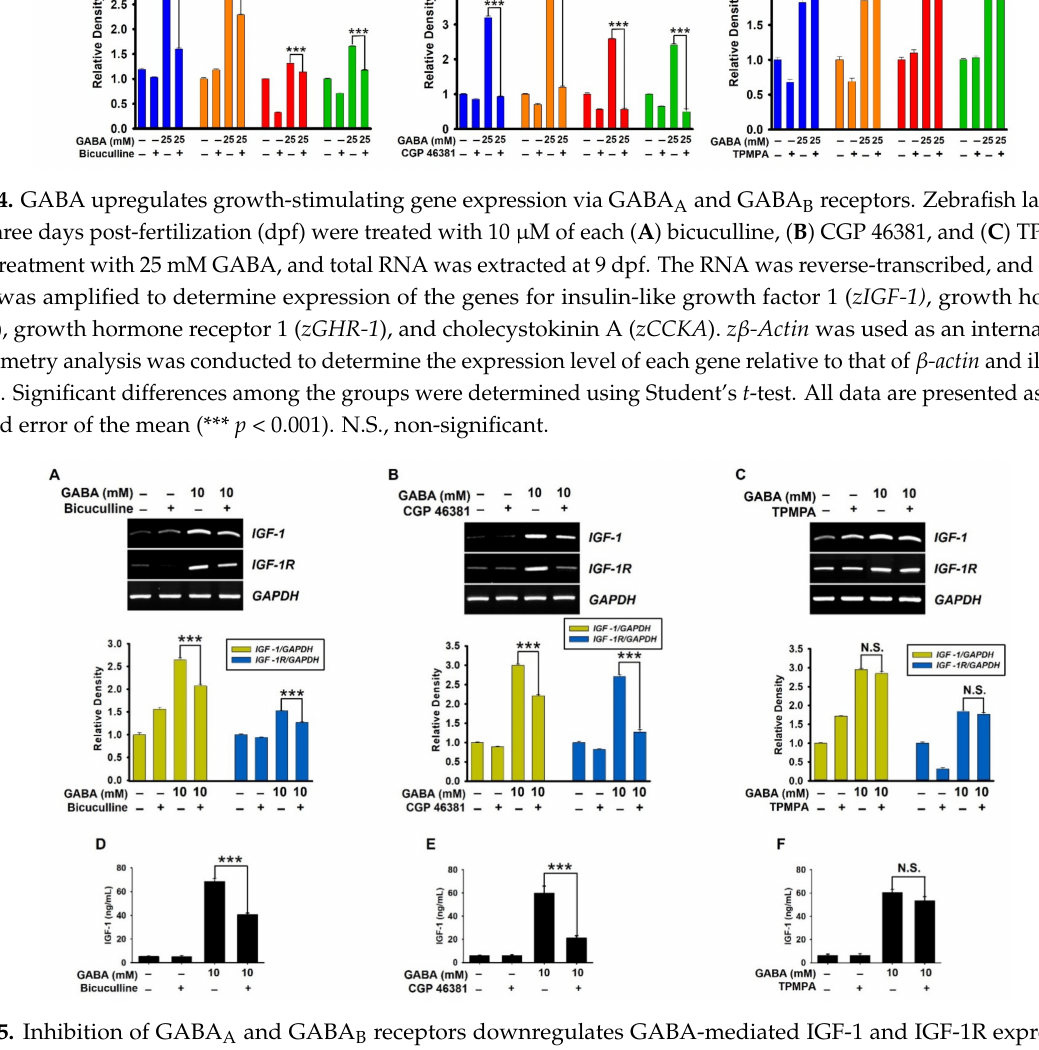
Figure 5. Inhibition of GABA A and GABA B receptors downregulates GABA-mediated IGF-1 and IGF-1R expression in preosteoblast MC3T3-E1 cells. MC3T3-E1 cells (1 × 10 4 cells/mL) were treated with 5 µ M each of ( A , D ) bicuculline, ( B , E ) CGP 46381, and ( C , F ) TPMPA 2 h before treatment with 10 mM GABA for seven days. Total RNA was extracted, and RT-PCR was performed to determine the expression level of IGF-1 and IGF-1R . Glyceraldehyde 3-phosphate dehydrogenase gene ( GAPDH ) was used as an internal control. The expression of IGF-1 and IGF-1R relative to that of GAPDH level was determined ( bottom ). In a parallel experiment, cell-free supernatants were collected, and ELISA was conducted. Significant differences among the groups were determined using Student’s t -test. All data are presented as mean ± standard error of the mean (*** p < 0.001). N.S.,